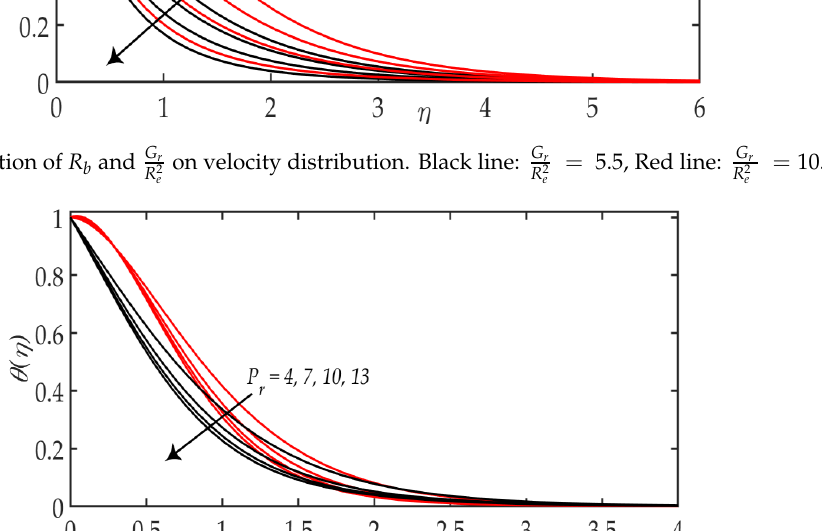
Figure 5. Variation of 𝑃 𝑟 and 𝑀 on temperature profile. Black line: 𝑀 = 0 , Red line: 𝑀 = 3.